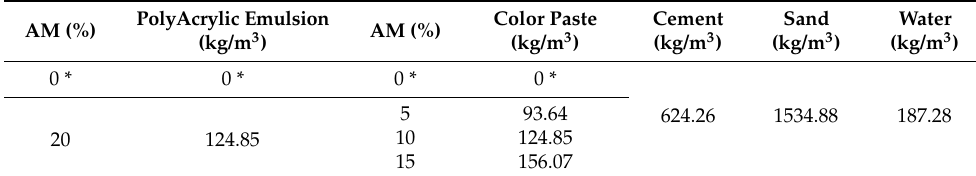
Table 3. W/C 0.4 Mixture proportions of